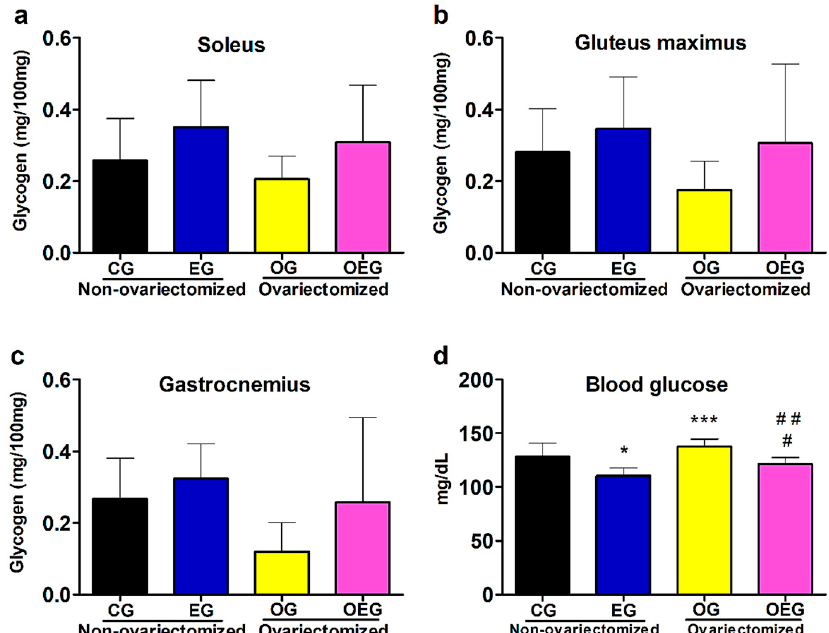
Figure 2. Data from muscular glycogen of the soleus ( a ), gluteus maximus ( b ) and gastrocnemius ( c ), as well as blood glucose ( d ) in the control group (CG; n = 10), ovariectomized group (OG; n = 10), exercised group (EG; n = 9) and ovariectomized and exercised group (OEG; n = 9). Values expressed as mean and standard deviation. The statistics provided in the graphs are the results of the Newman–Keuls post hoc test: * p < 0.05 EG in relation to CG; *** p < 0.05 OG in relation to EG; # p < 0.05 OEG in relation to EG; ## p < 0.05 OEG in relation to OG. mg: milligrams; dL: deciliters.